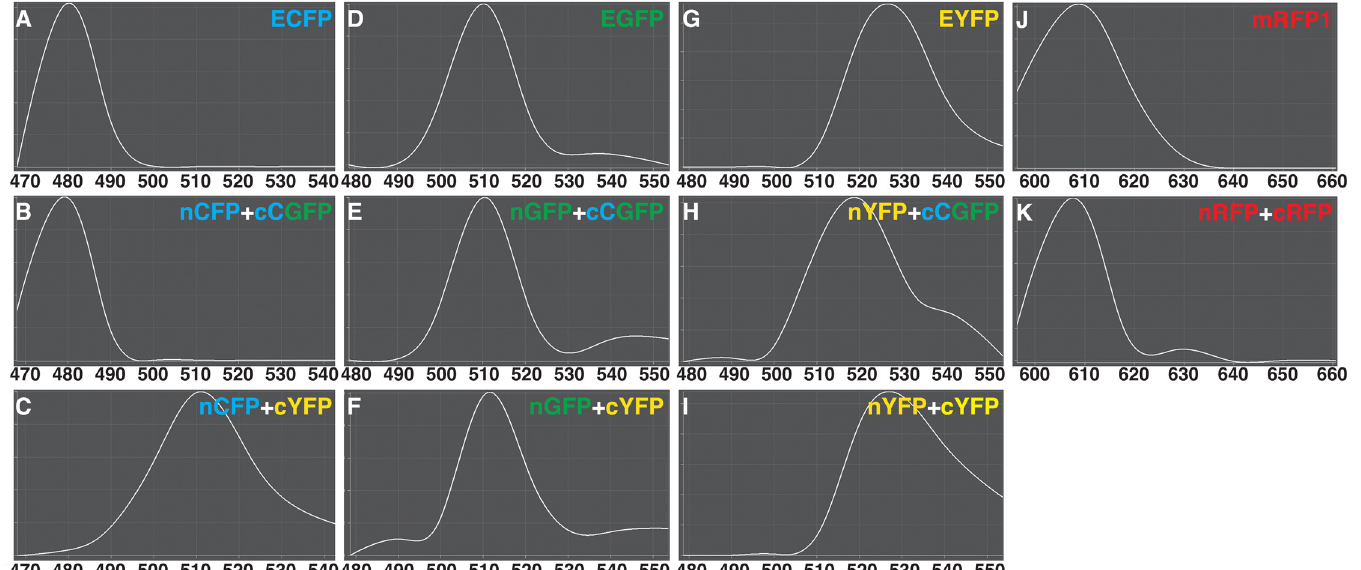
Fig 4. Fluorescence emission spectra of intact and reconstituted fluorescent proteins. Using the interaction between PEX7 and PTS2 as one of the split combinations transiently expressed in onion epidermal cells, florescence emission spectra were measured following excitation with an argon laser at 458 nm (A – L) or a HeNe laser at 543 nm (J, K) using the LSM510 META system. X- and Y-axes represent wavelength and relative fluorescence intensity, respectively. The maximum emission of each spectrum was taken as 1.0, and in each curve, fluorescence at a given wavelength was normalized relative to the maximum. (A) non-split ECFP, (B) nCFP with cCGFP, (C) nCFP with cYFP, (D) non-split EGFP, (E) nGFP with cCGFP, (F) nGFP with cYFP, (G) non- split EYFP, (H) nYFP with cCGFP, (I) nYFP with cYFP, (J) non-split mRFP1 and (K) nRFP with cRFP.